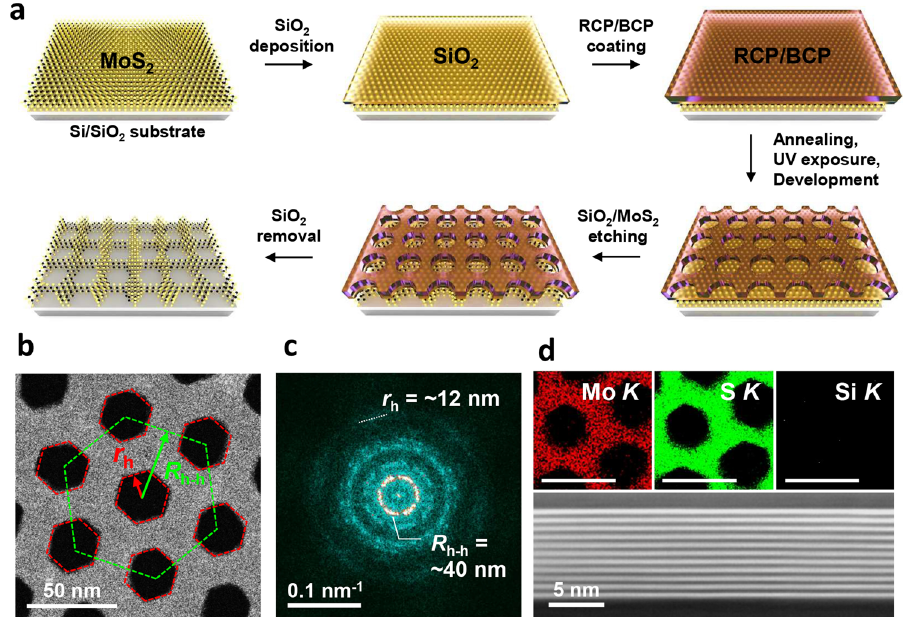
Fig. 1 Preparation and microscopic characterization of the nano-patterned MoS 2 multilayer. a A schematic illustration of nano-scale patterning process on multilayer MoS 2 . b ADF-STEM image showing an array of nanoholes in the multilayer MoS 2 . c FFT pattern representing a crystallographic hexagonal array of hexagon holes (from Supplementary Fig. 3a). d STEM-EDX elemental mapping (top panels) for Mo K , S K , and Si K peaks (scale bars of 50 nm) and cross-sectional view (bottom panel) of the multilayer nanoporous MoS 2